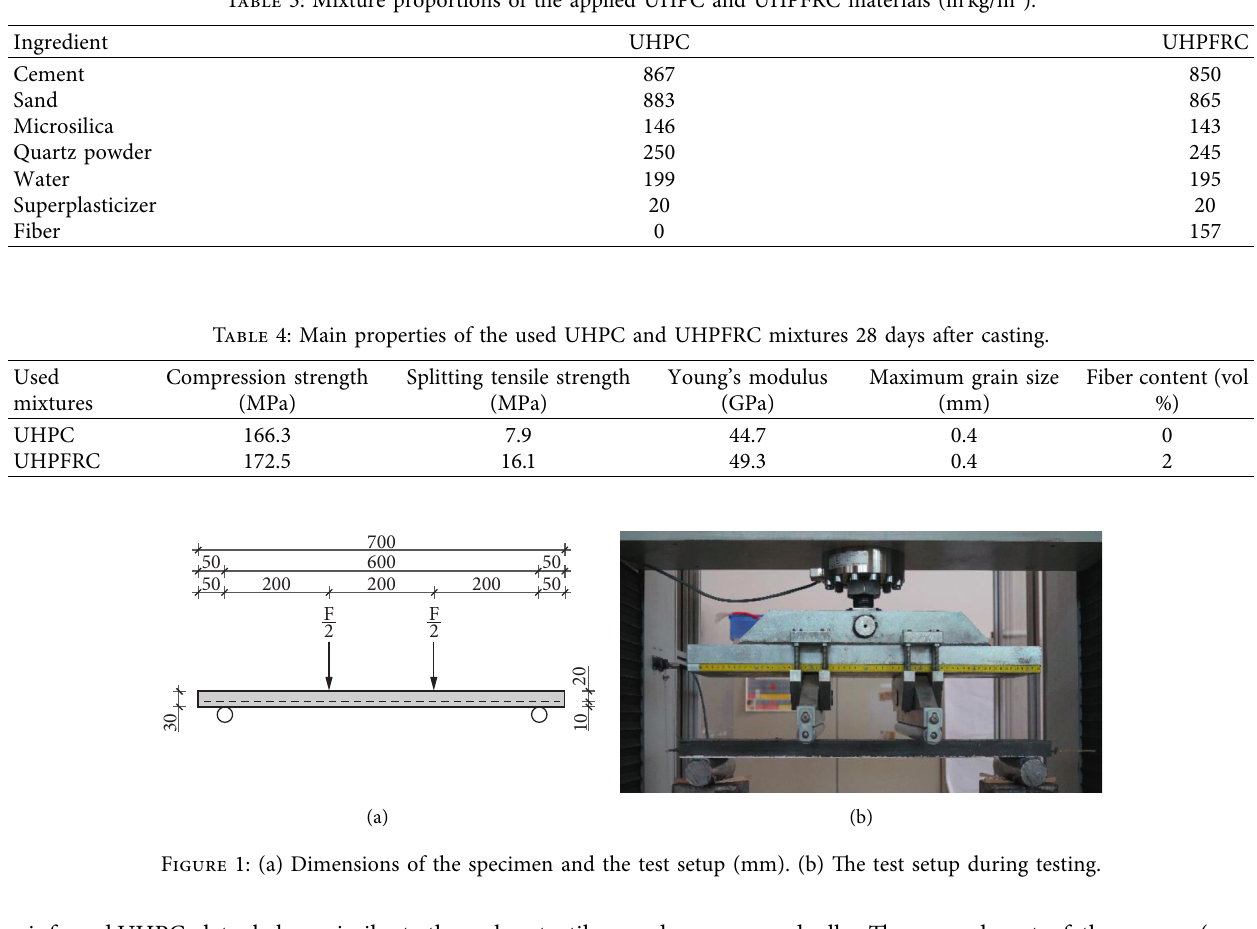
Table 3: Mixture proportions of the applied UHPC and UHPFRC materials (inkg/m 3 ).